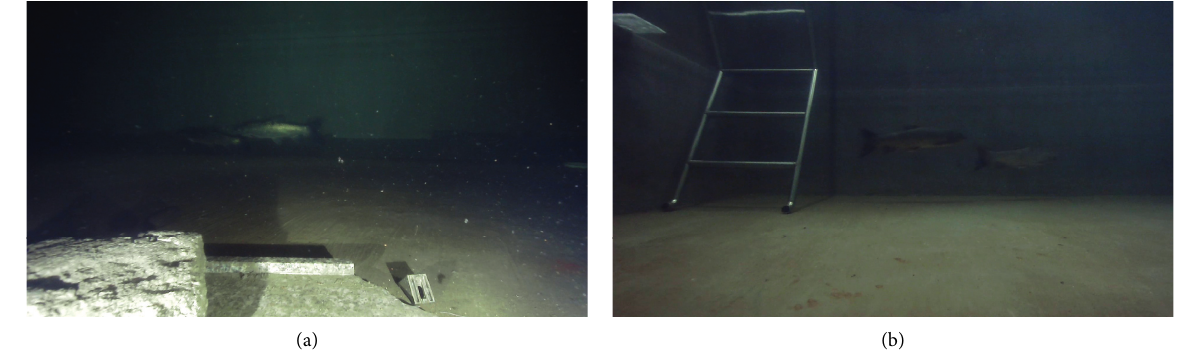
Figure 6: Examples of image of grass carp sample of low quality.